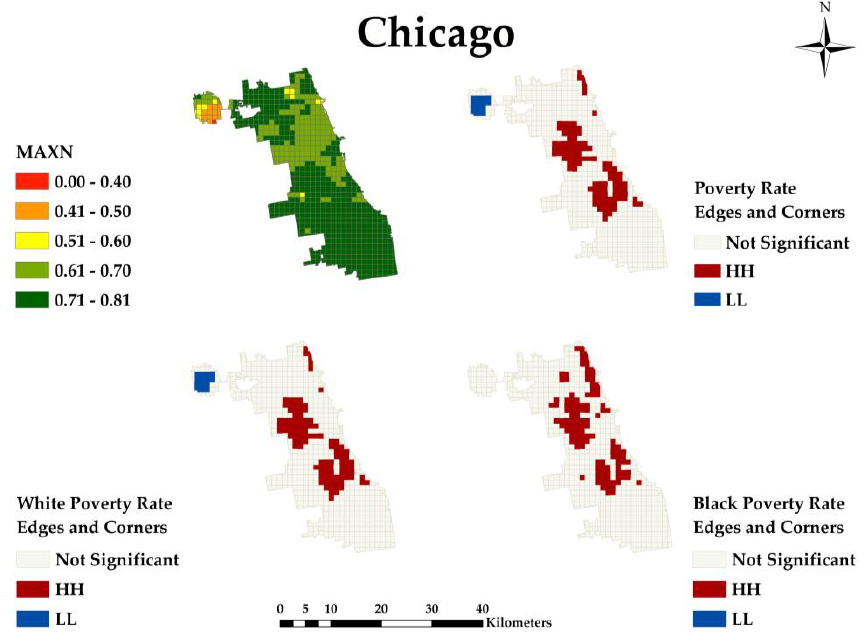
Figure 2. The Local Indicators of Spatial Association (LISA) maps of Chicago shrinking city: MAXN, Poverty Rate, White Poverty Rate, and Black Poverty Rate.